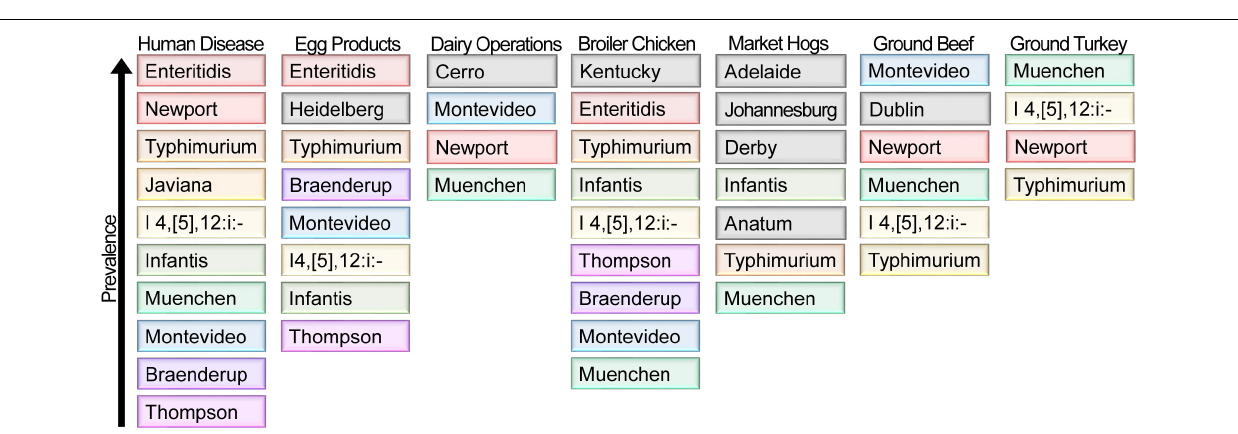
FIGURE 7 | NTS serovar prevalence from reported human clinical cases of salmonellosis and surveillance of different animal food sources. The ten serovars most frequently identified in human disease (colored) are listed in order of their prevalence for each of the indicated sources (United States Department of Agriculture [USDA], 2014, 2017; Centers for Disease Control and Prevention [CDC], 2016; Sonnier et al., 2018). When a serovar represents > 10% of Salmonella identified from a source other than humans, it is shown in gray under that